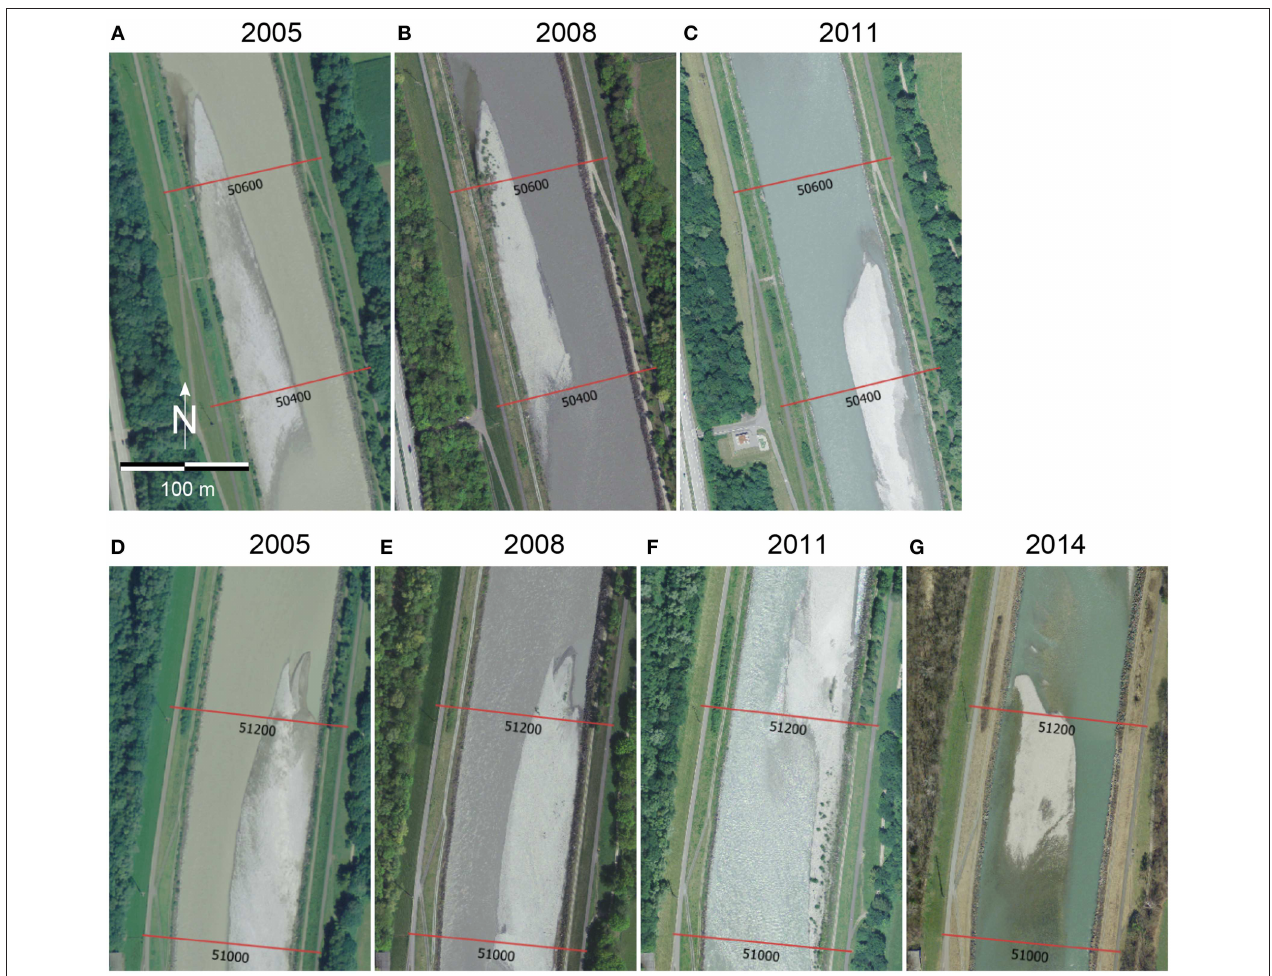
FIGURE 6 | Example of vegetation establishment on two bars in reach B. Bar at km 50.60 developed some sparse vegetation in 2008 (A,B) , but it was then removed before 2011 because of large downstream migration (C) . Similarly, at km 51.20 the bar developed sparse vegetation from 2005 to 2008 (D,E) , which persisted till 2011 despite bar migration (F) , but was completely removed in the period 2011-2014 (G) . Cross section locations are indicated with red continuous lines. Flow direction is from bottom to